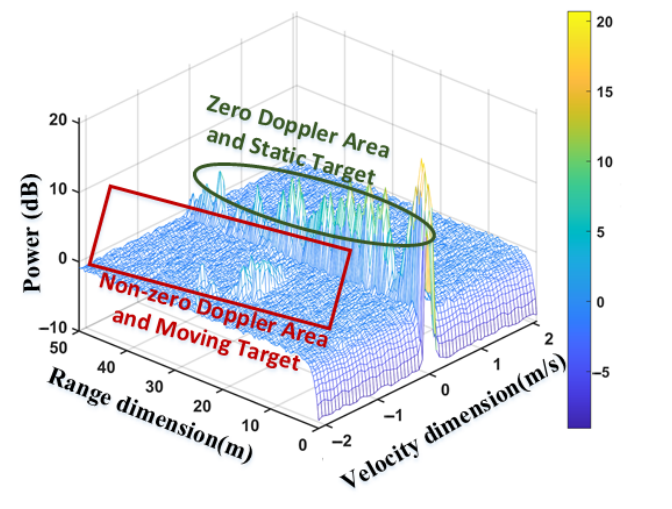
Figure 6. The RDM detection